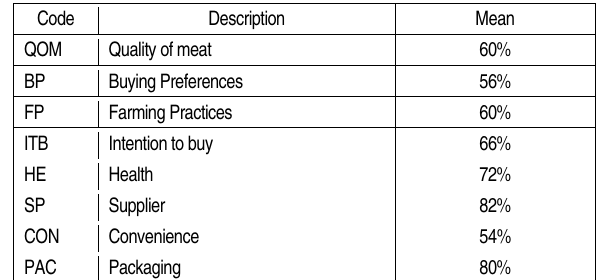
Table 5: Mean scores – Beef purchasing